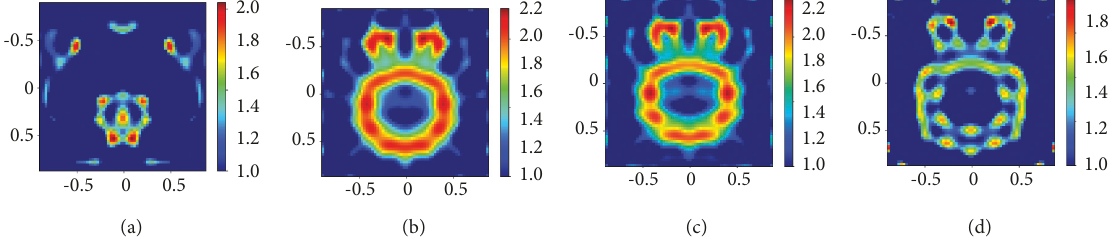
Figure 3: The CSI inversion results of the Austria profile with ε 1.5 (b), 2 (c), and − 2i (d) in the forward simulation. (a) E